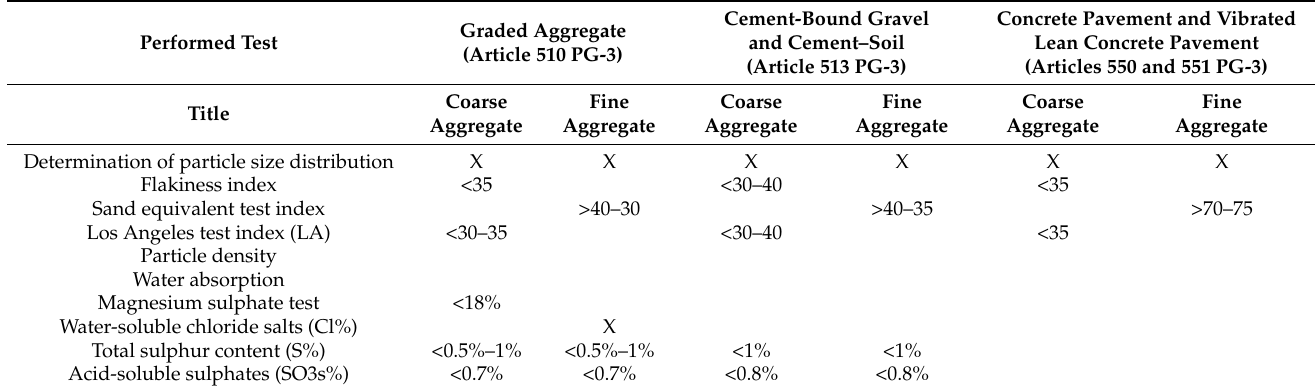
Table 1. PG-3 technical requirements for graded aggregate, cement-bound gravel and lean concrete pavement